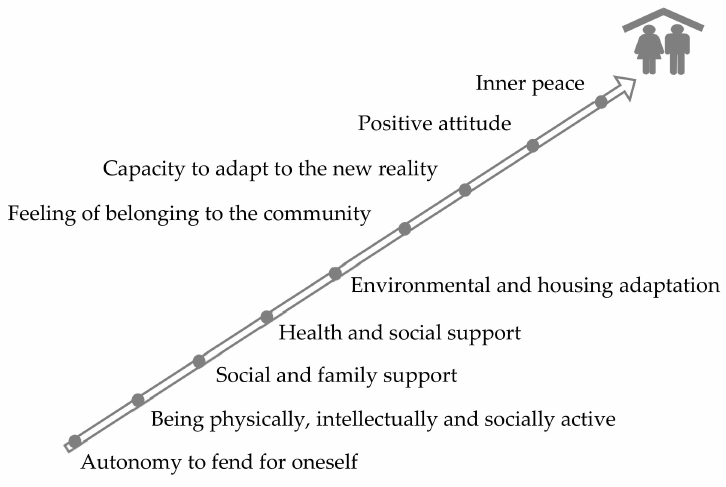
Figure 4. Enablers to HA in